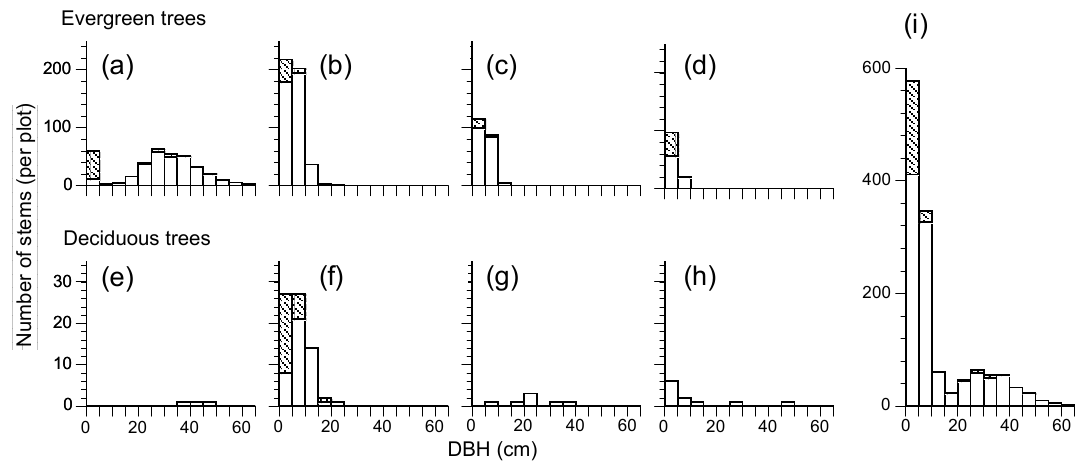
Figure 2. Diameter at breast height (DBH) class distributions of the main four evergreen and deciduous broad-leaved species and all tree stems in the permanent plot in 2017, ( a ): Castanopsis cuspidata ; ( b ): Cleyera japonica ; ( c ): Eurya japonica; ( d ): Quercus glauca; ( e ): Ilex micrococca; ( f ): Ilex macropoda; ( g ): Magnolia obovata ( h ): Eleutherococcus sciadophylloides; ( i ): Total. Hatched areas represent sprouting stems from root suckers (the area of per plot was 0.7 ha).